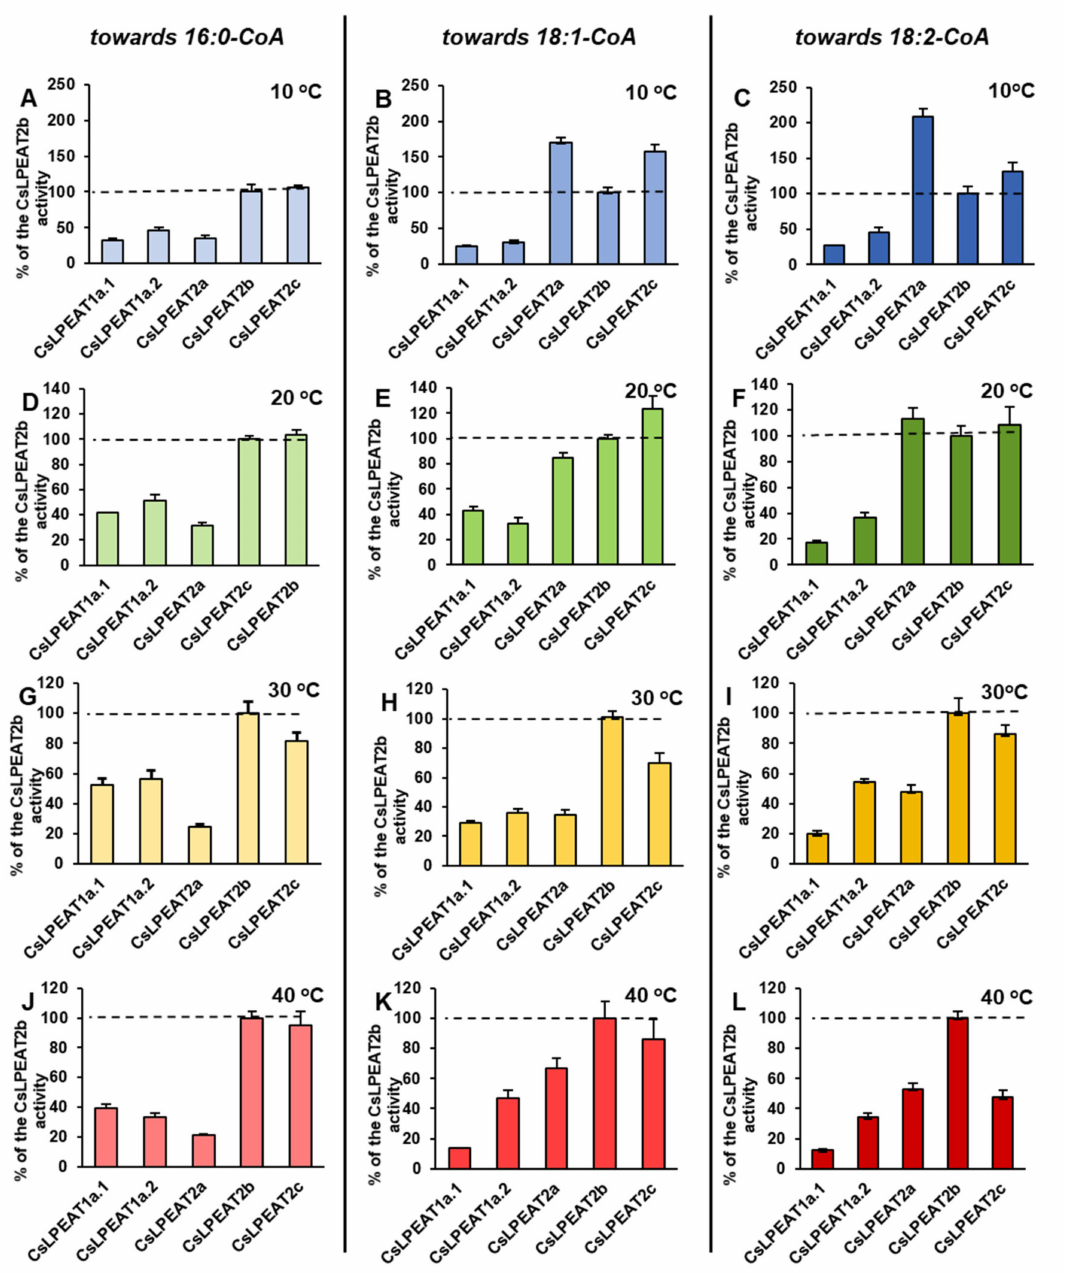
Figure 7. Preferences towards different acyl donors of Cs LPEAT isoforms at different temperatures. Activities of Cs LPEAT isoforms are presented in corresponding panel: towards 16:0-CoA ( A , D , G , J ), towards 18:1-CoA ( B , E , H , K ), towards 18:2-CoA ( C , F , I , L ). Activities are expressed as percentages of Cs LPEAT2b activity with a particular acyl-CoA. The data presented in Figure 6 were used for the calculations. Error bars indicate the SD between at least three repeats ( n ≥